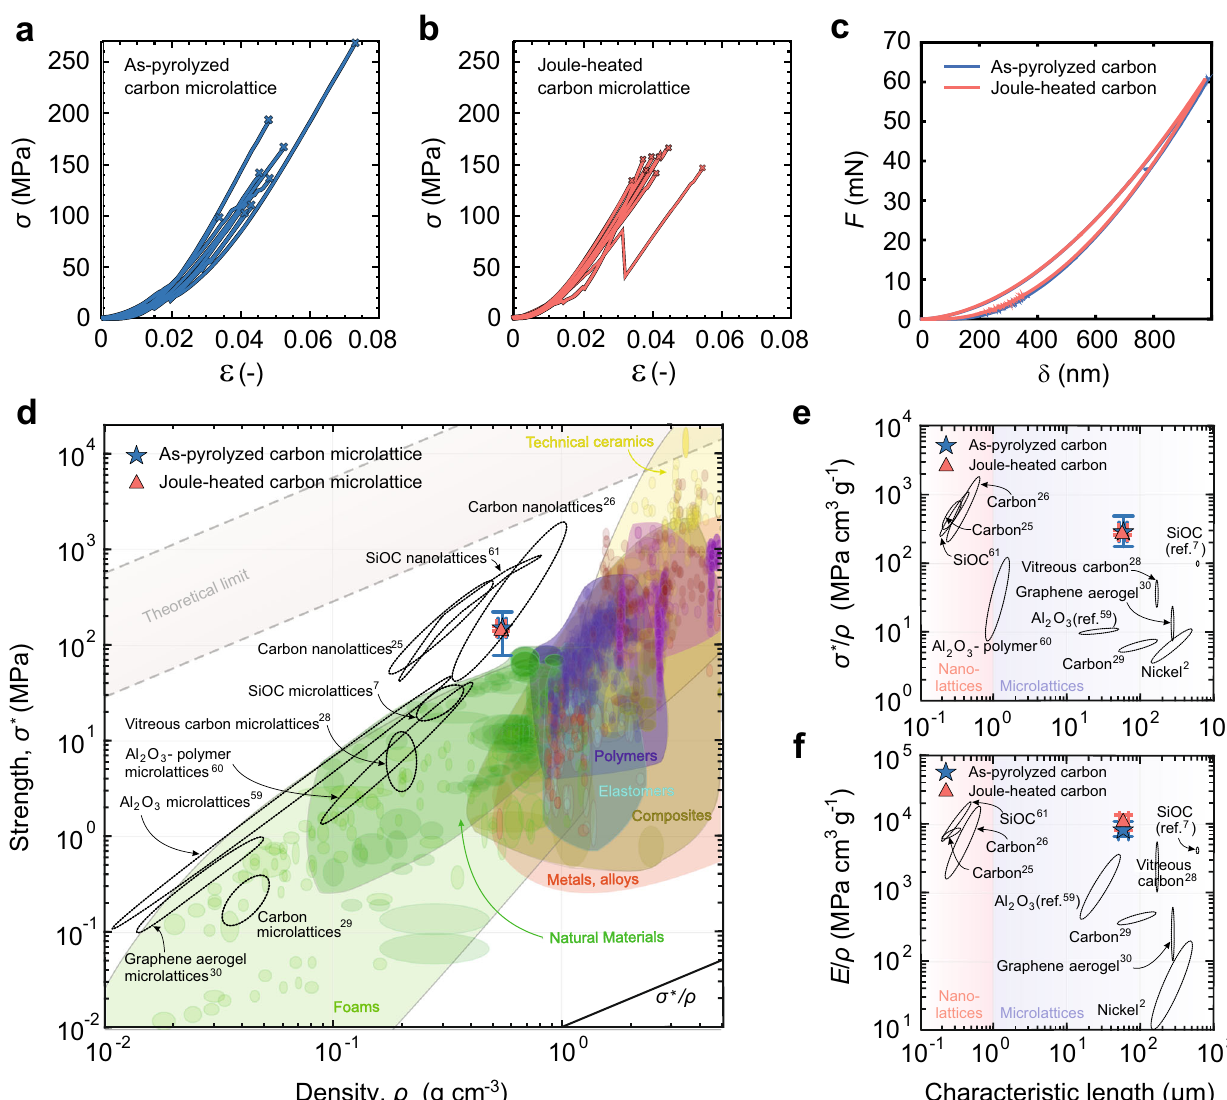
Fig. 5 Compressive mechanical properties for pyrolytic and Joule-heated carbon microlattices. Engineering stress-strain curves from micromechanical compression experiments on as-pyrolyzed ( a ) and Joule-heated ( b ) carbon microlattices. c Load versus displacement curves from nanoindentation tests performed on internal cores of beams. d Strength versus density plot of the fabricated microarchitectures in the context of structural materials (CES Edupack 2018, Granta Design) and high-strength micro- and nanolattices. Comparison of the speci fi c strength ( e ) and speci fi c stiffness ( f ) versus characteristic length (strut width) for micro- and nanoarchitectures. With two orders of magnitude larger strut diameter, the carbon lattices in this work attain properties that approach those of the strongest nanoarchitectures created up to date, outperforming all existing microlattices. Error bars indicate standard